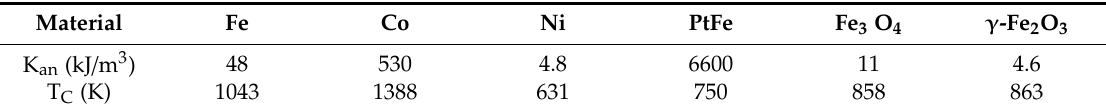
Table 1. Bulk magnetocrystalline anisotropy constant, K an , Curie temperature, Tc, for representative magnetic materials. Data compiled from data included in